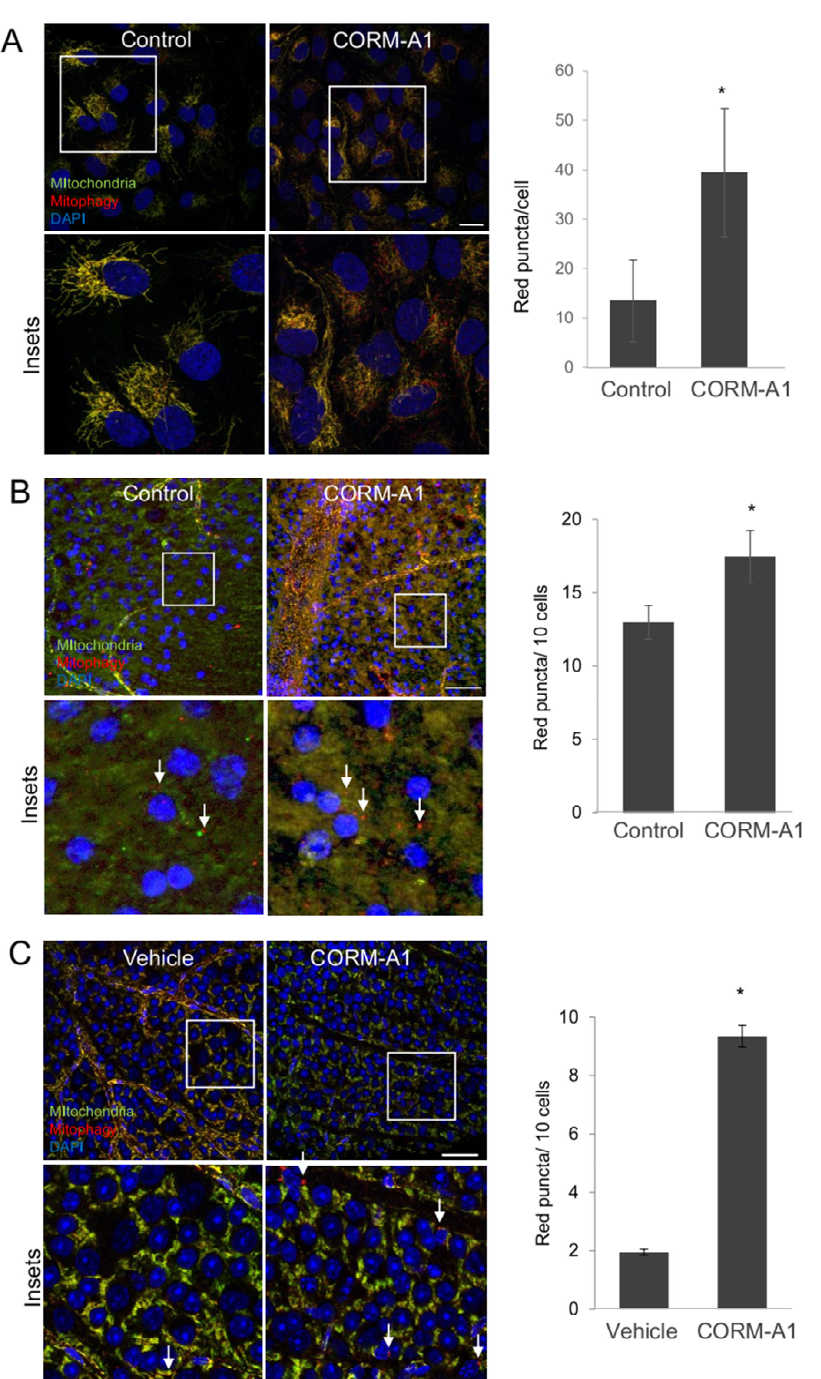
Figure 6. CORM-A1 induces mitophagy, in vitro, ex vivo and in vivo. ( A ) ARPE-19 mito -QC cells were incubated with CORM-A1 for 24 h and the number of red-only puncta was quantified in at least 30 cells from the confocal images. Scale bar 20 µm. ( B ) Retinal explants from the mito -QC animals were incubated with CORM-A1 for 8 h. Representative confocal images at the quantification of the number of red-only dots are displayed. Magnifications show representative pictures of mitophagy positive cells in the RGCL, scale bar 25 µm. C. mito -QC animals were treated with daily intraperitoneal CORM-A1 injections for 7 subsequent days, before analyzing mitophagy red-only puncta in the RGC layer. Figure 6( C ) shows pictures of the RGC layer as an overview as well as a magnification and the graph display the quantification of red-only puncta in the RGCL, labeled with white arrows. Scale bar 25 µm. RGCL, retinal ganglion cell layer. * p < 0.05.